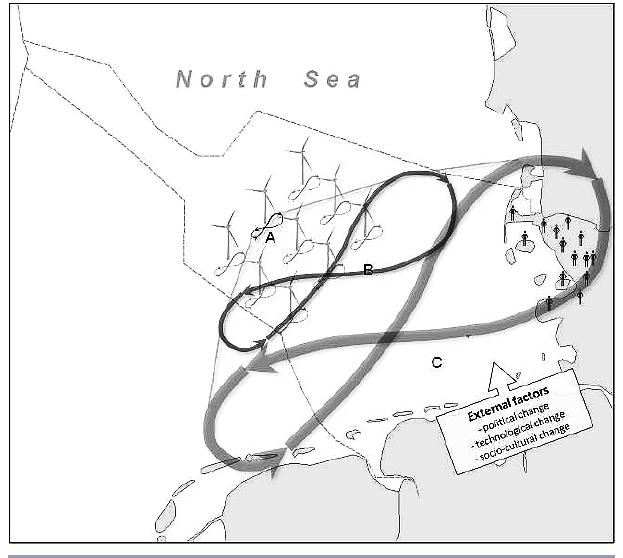
Fig. 7 . Panarchy of adaptive cycles acting at different spatial scales: A) individual turbine pile, B) offshore wind farm (OWF)/seascape, C) coastal